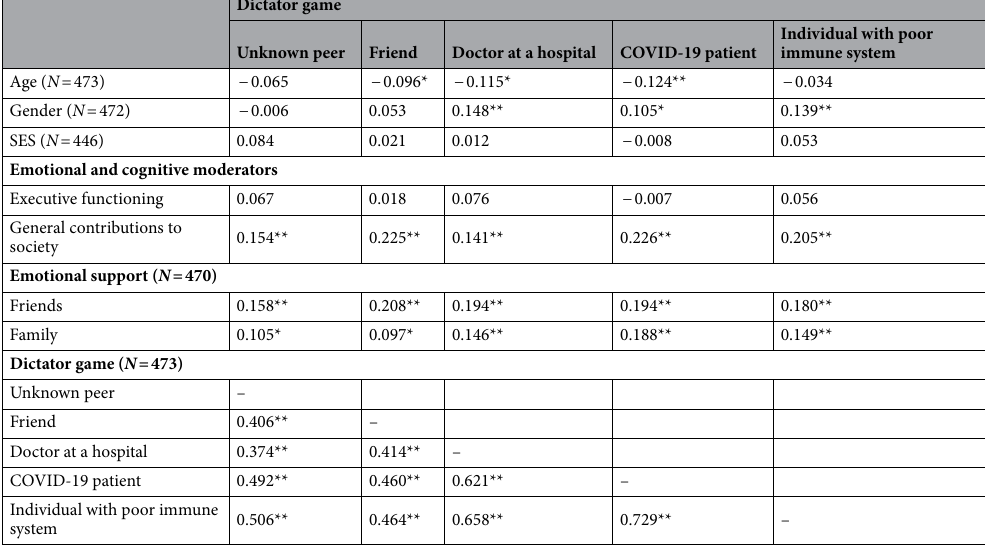
Table 3. Bivariate correlations among all variables used in the statistical analyses (at T2). * p < 0.05, ** p < 0.01.